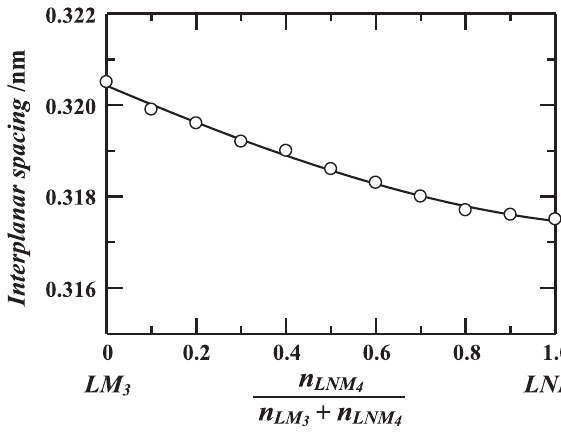
/( n LM + n LNM 4 3 4